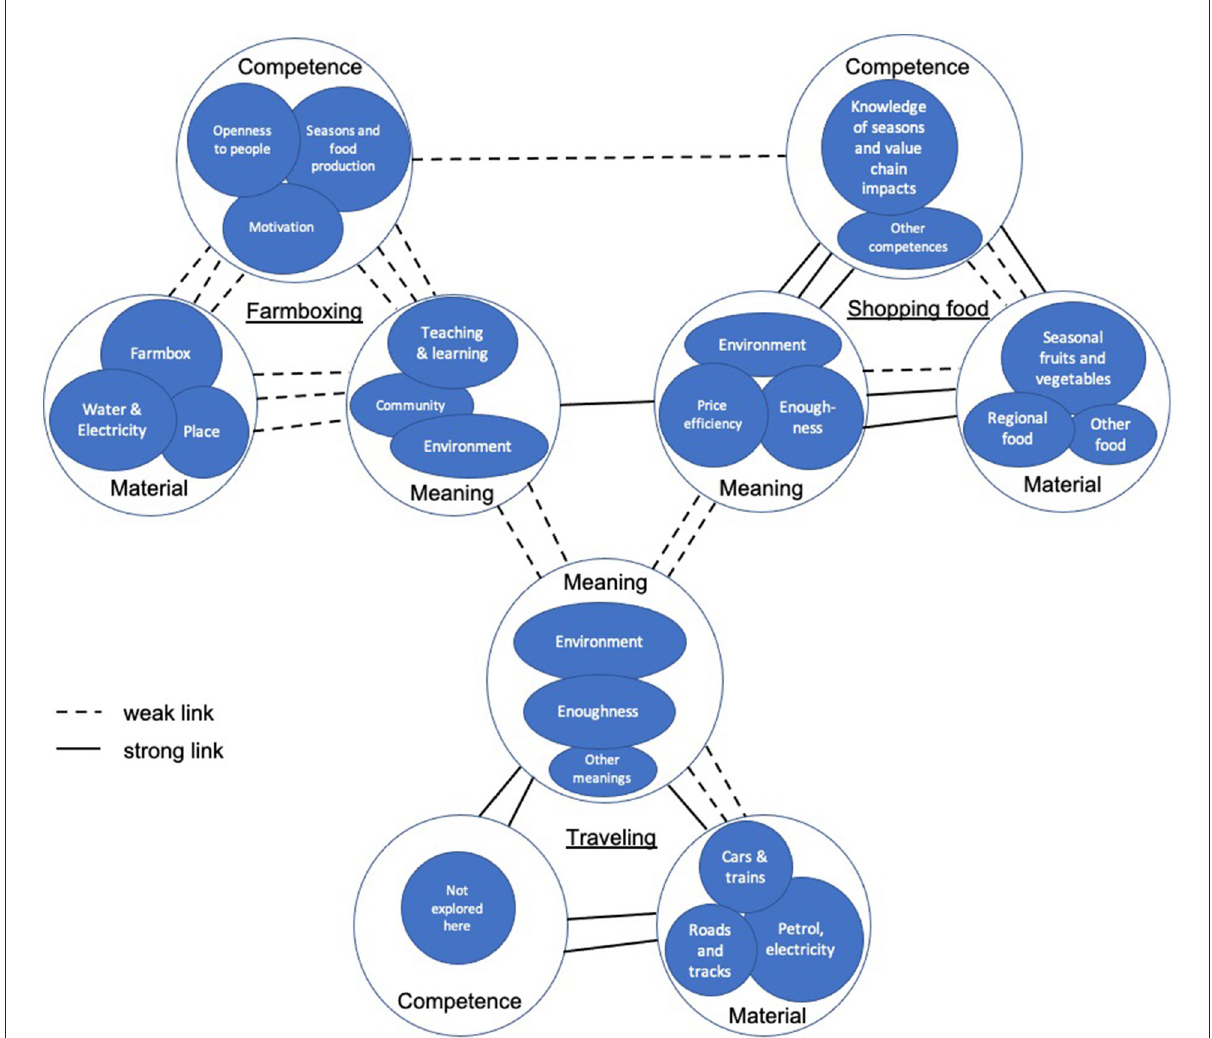
FIGURE2 Extract from a network of social practices linked to Farmboxing through shared meanings and competences. Weak links are newly developed or contested, strong links are more established and less contested. The number of links is exemplary and materials, competences, and meanings are not